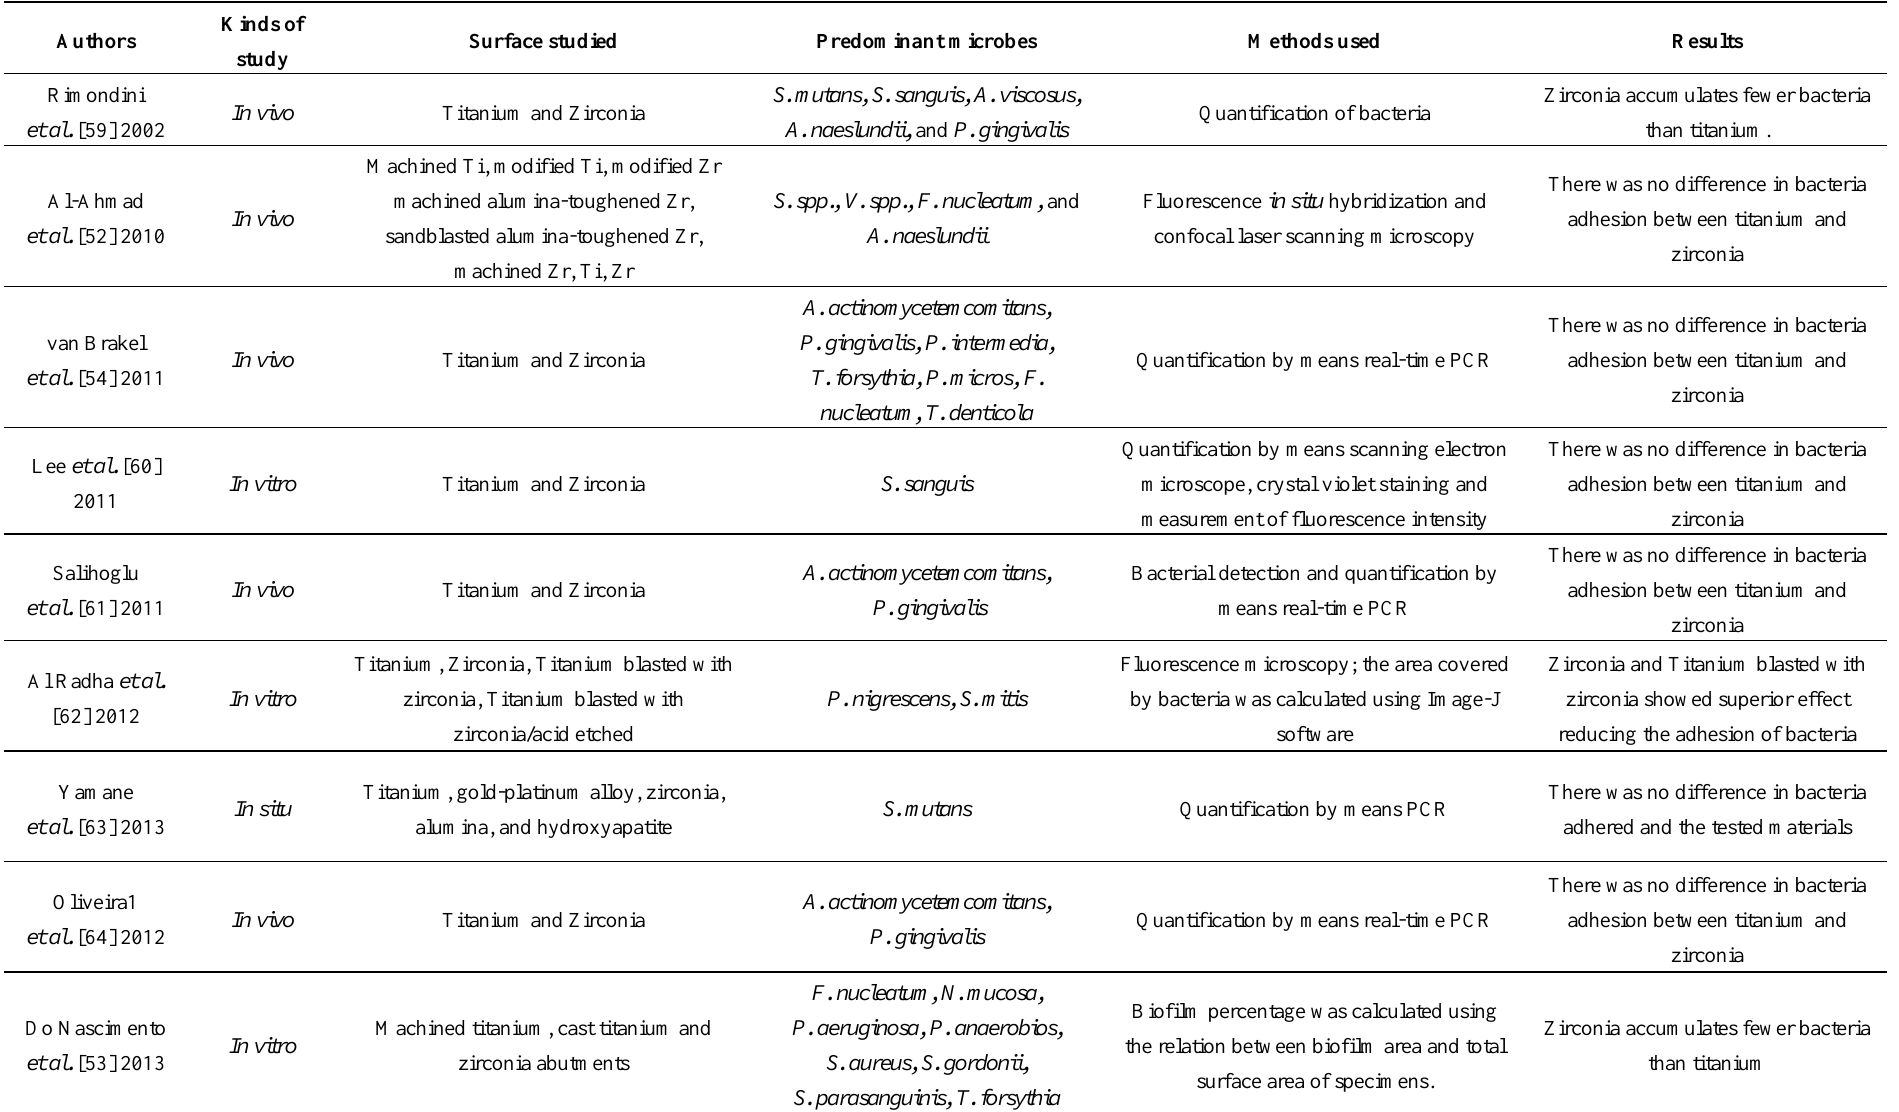
Table 1. Studies presenting data on microbiology associated with abutments dental